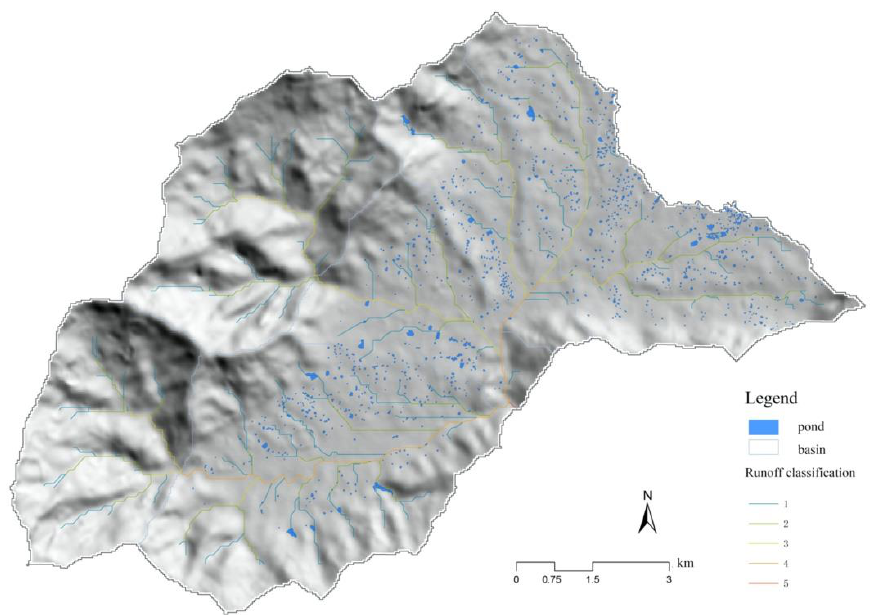
Figure 13. The runoff classification result for the Beitang landscape.